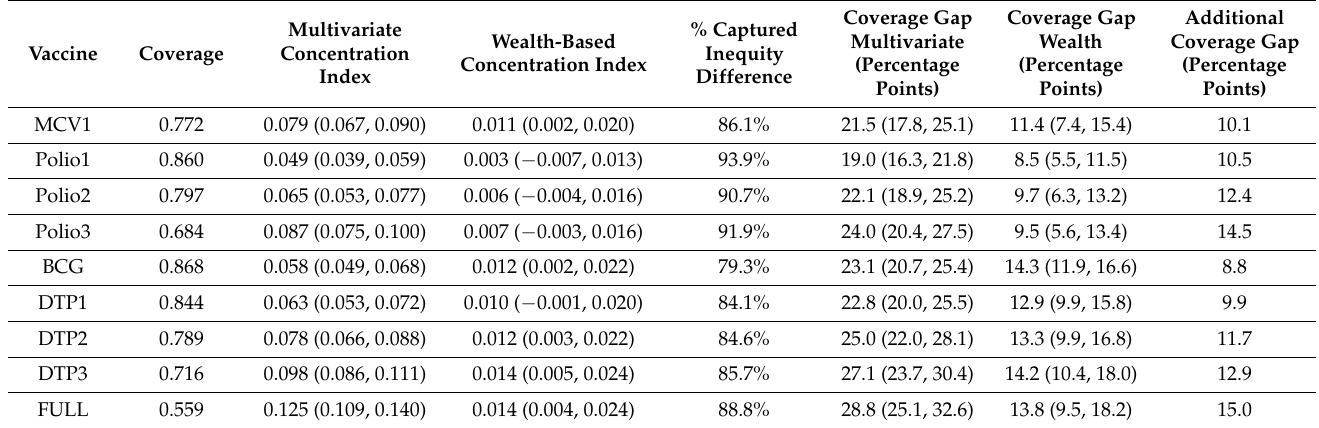
Table 1. Average inequities among 56 studied countries, by